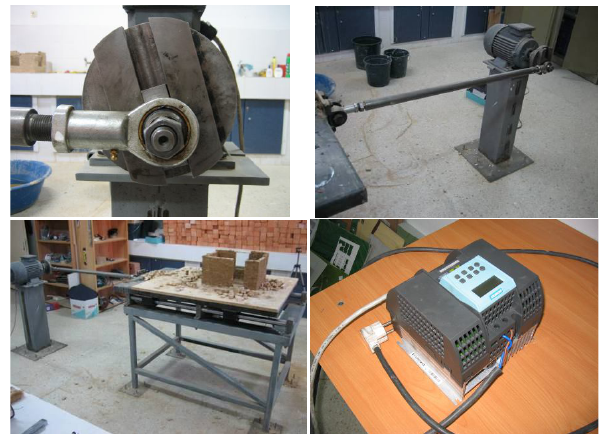
Fig. 3 Custom made shaking table test setup Fig. 3. Custom made shaking table test